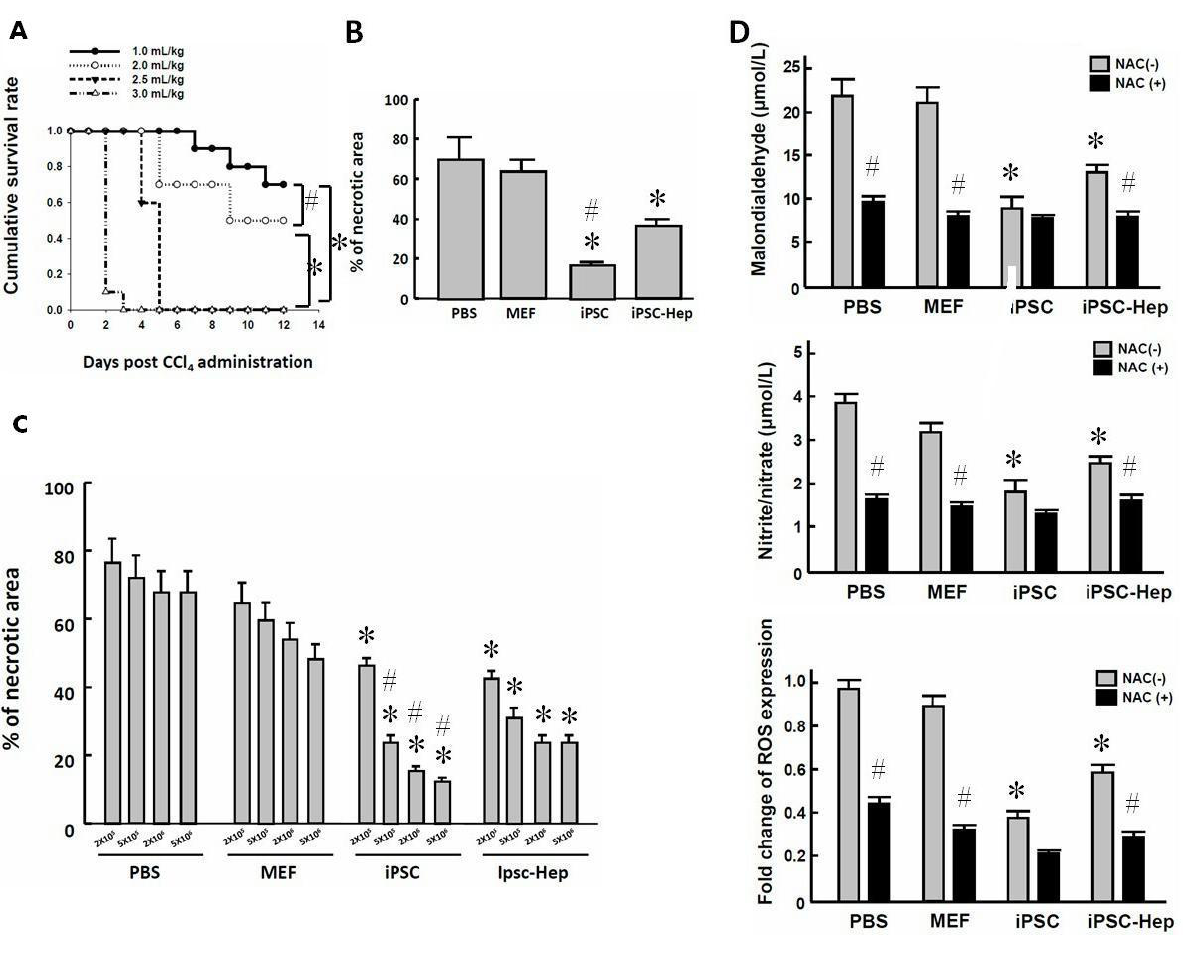
Figure 4. Effect of intraperitoneal cell transplantation (PBS, mouse embryonic fibroblasts (MEFs), iPSCs, or iPSC-Heps) on the hepatic pathology in CCl -treated mice. 4 ( A ) Determination of the optimal dose for the induction of acute hepatic failure (AHF) by intraperitoneal administration of CCl into BALB/c nude mice. 2.5 mL/kg body CCl was 4 4 used as the standard treatment; ( B ) Quantification of H&E-stain of CCl -treated liver tissue 4 from recipients; ( C ) Quantification of H&E-stained liver sections from CCl -treated mice 4 that received PBS injection, transplantation of MEFs, 3-genes iPSCs, or 3-genes iPSC-Heps at 2 × 10 5 , 5 × 10 5 , 2 × 10 6 , and 5 × 10 6 cells /kg body wt; ( D ) Changes in ROS levels (left), MDA content (middle), and nitrite/nitrate content (right) in the CCl -injured livers of 4 recipients in all groups with and without N -acetyl-cysteine (NAC) pretreatment. Data shown here are the mean ± SD of six independent experiments. In panel A, * P < 0.05 vs . 2.5 mL/kg body wt, # P < 0.05 vs . 2.0 mL/kg body wt. In panel B, * P < 0.05 vs . PBS or MEFs. # P < 0.05 vs . iPSC-Heps. In panel C, * P < 0.05 vs . PBS or MEFs at the same cell doses. # P < 0.05 vs . iPSC-Heps at the same cell doses. In panel D, * P < 0.05 vs . PBS or MEFs, # P < 0.05 vs . corresponding to recipient with NAC